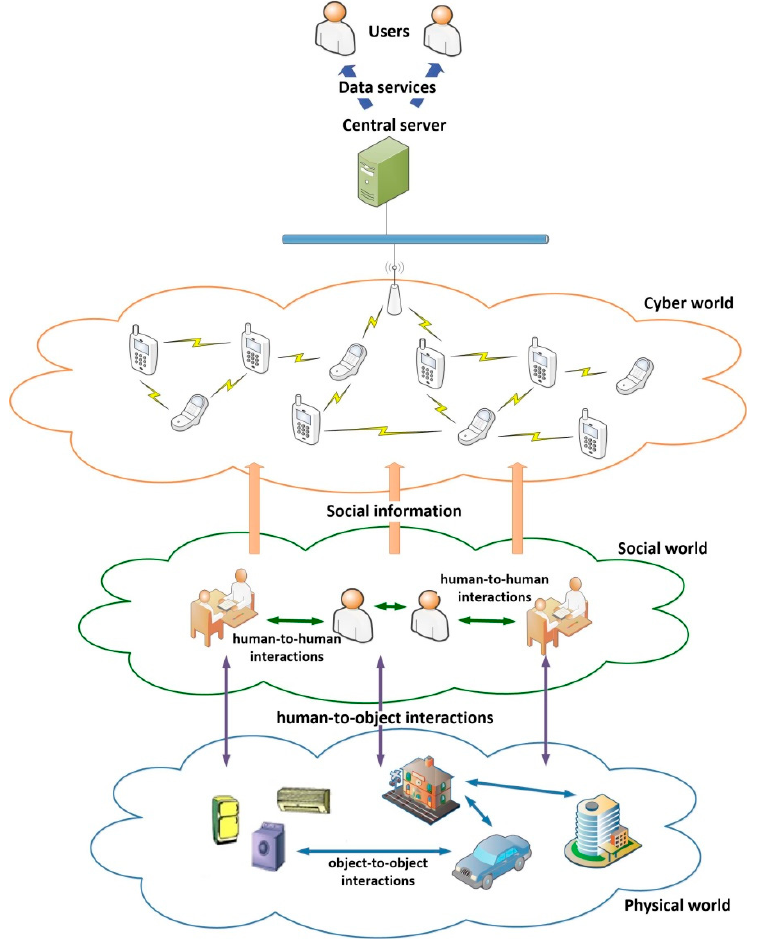
Figure 1. Cyber-Physical Social Sensing (CPSS) scheme.